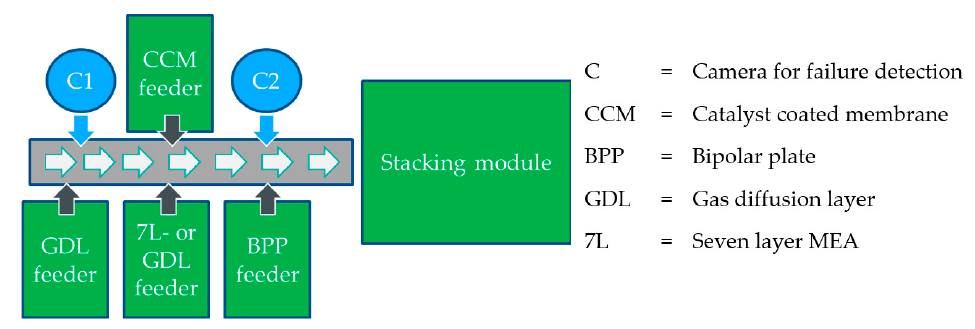
Figure 7. Schematic illustration of the modular mass manufacturing machine (MMM) as it is currently built (expansion stage 1).